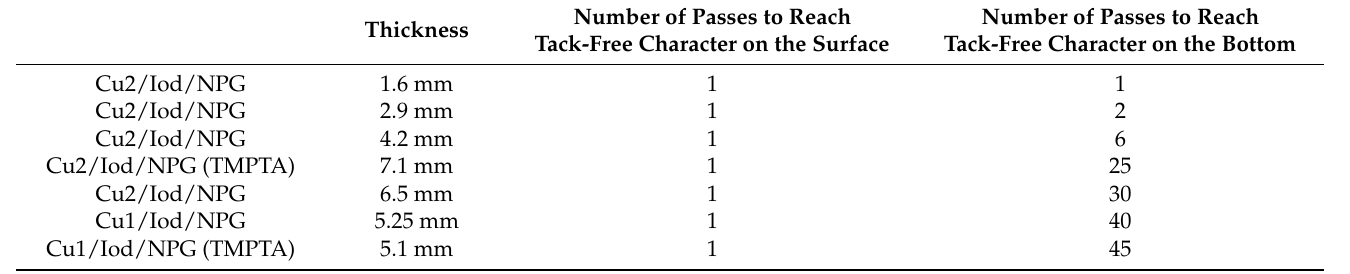
Table 6. Photocomposite synthesis results using TA as acrylic monomer (or TMPTA) and number of passes to reach the tack-free character on the surfaces. Number of Passes to Reach Number of Passes to Reach Thickness Tack-Free Character on the Surface Tack-Free Character on the Bottom